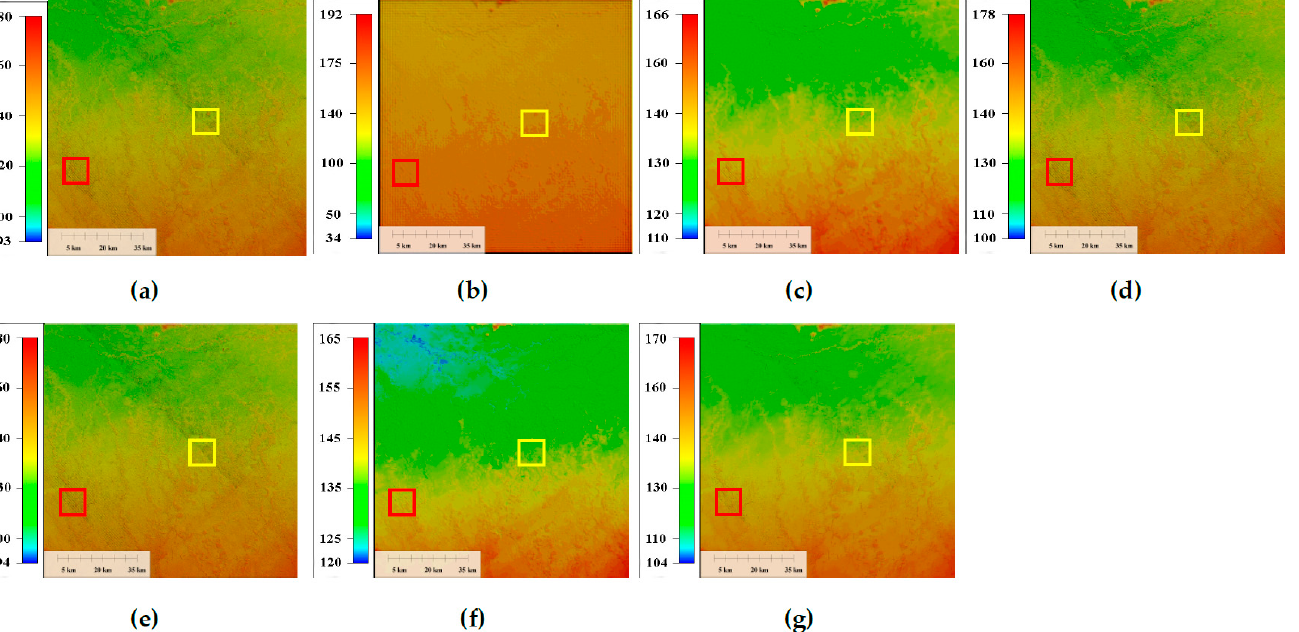
Figure 9. Results of the real experiment for area S31E147 (unit: meter). ( a ) Original S31E147 area, ( b ) low-pass filter, ( c ) TV, ( d ) UTV, ( e ) LRSID, ( f ) Gallant and ( g ) LRGS.